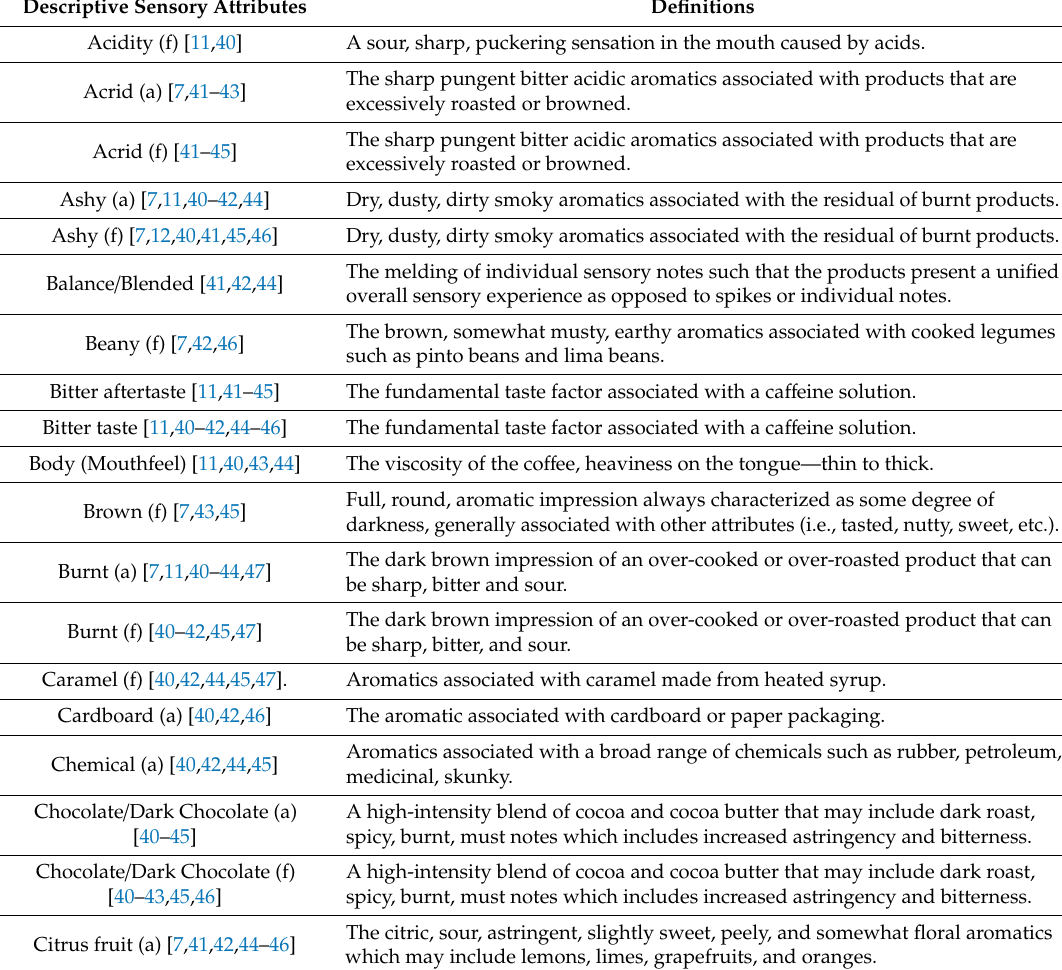
Table 1. Descriptive sensory properties used in studies to di ff erentiate brewed co ff ee samples 1 . Descriptive Sensory